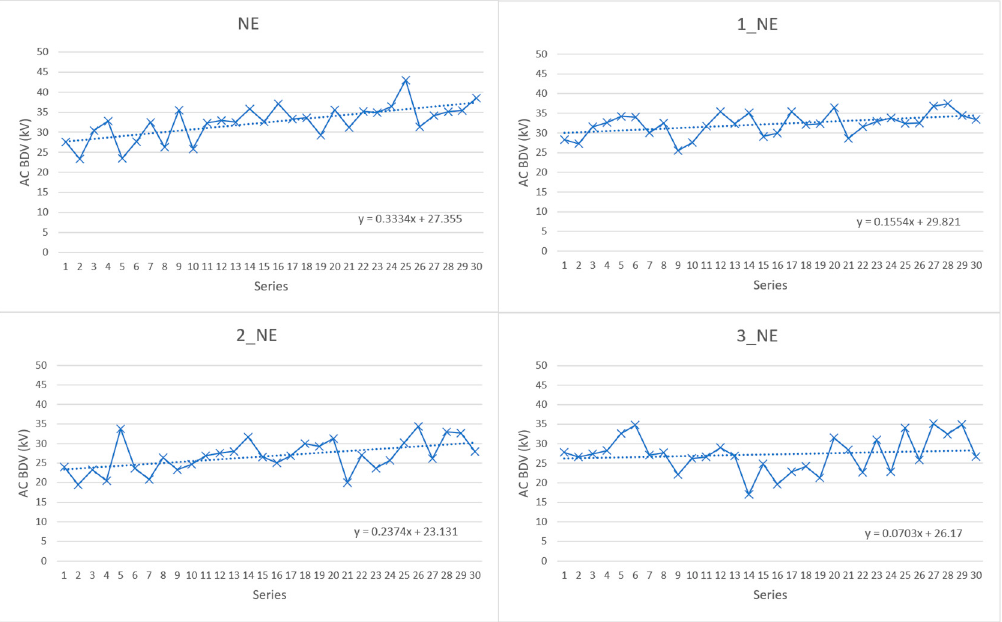
Figure 1. AC BDV distribution of NE-based nanofluids. The symbols indicate individual data points from successive measurements. The experimental data were fitted with a trending linear straight line by the equation displayed in the right bottom corner.